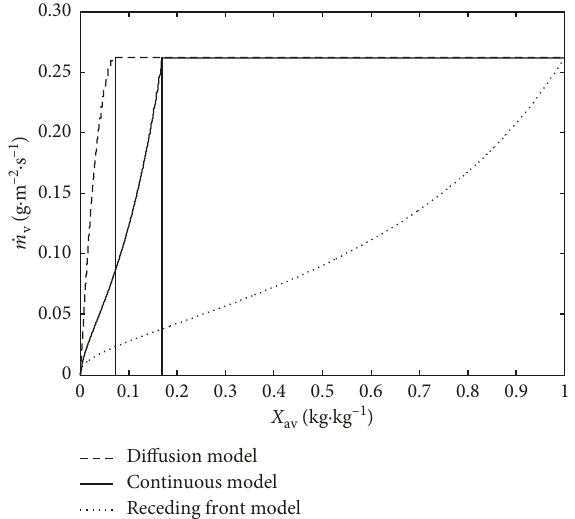
Figure 10: Evaporation rates for isothermal drying of a spherical particle using different drying models.